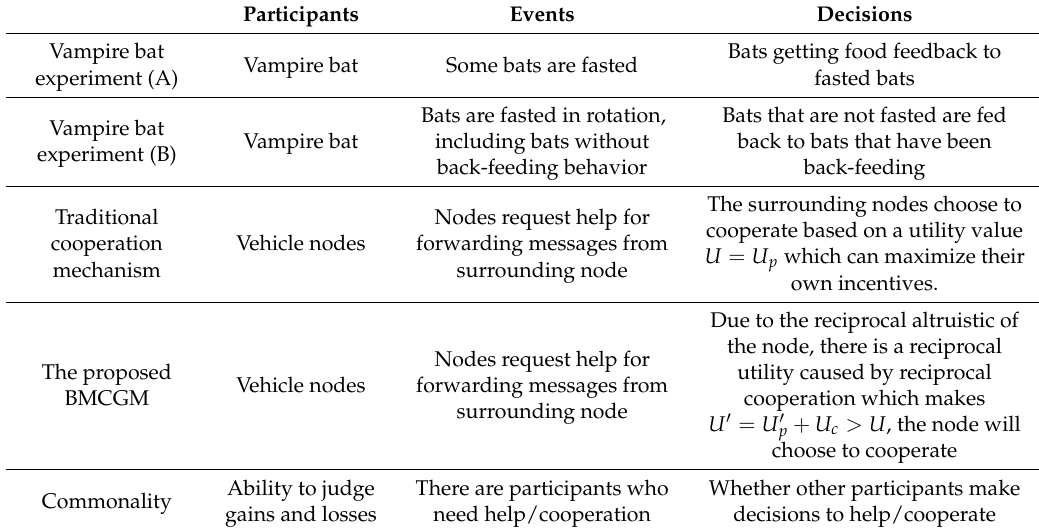
Table 1. The mapping of vampire bat experiment and incentive